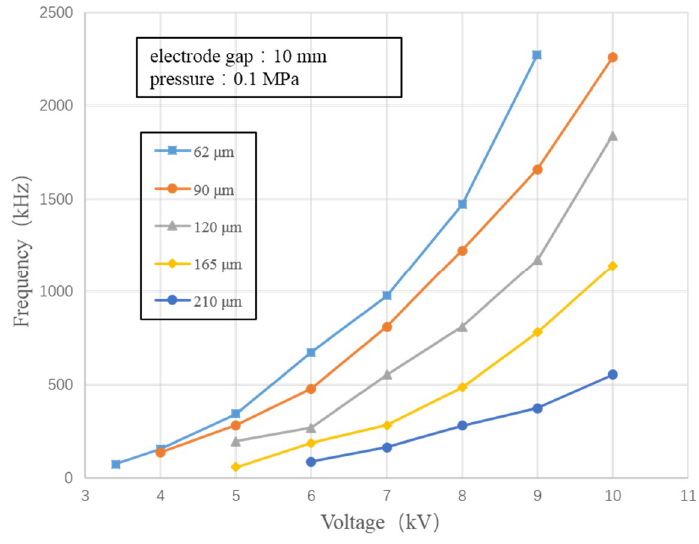
Figure 4. The relationship between Trichel pulse repetition frequency and applied voltage.